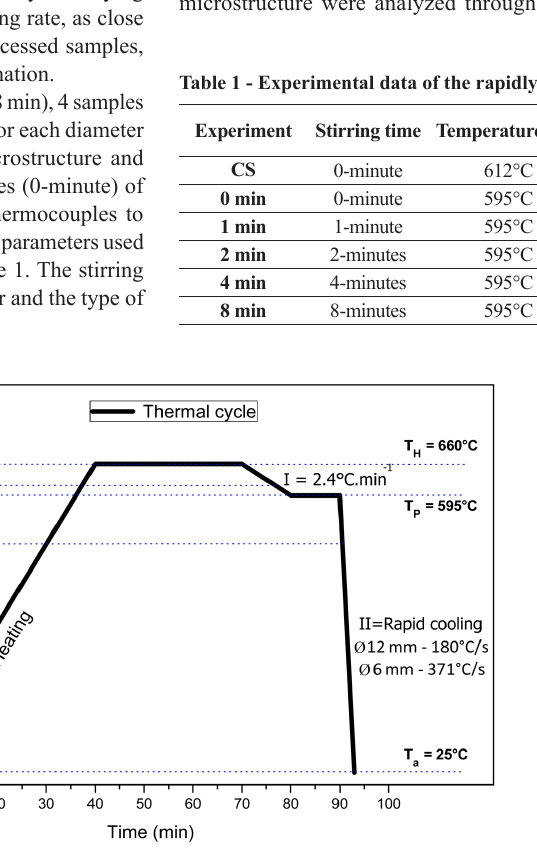
-Liquidus temperature; T L